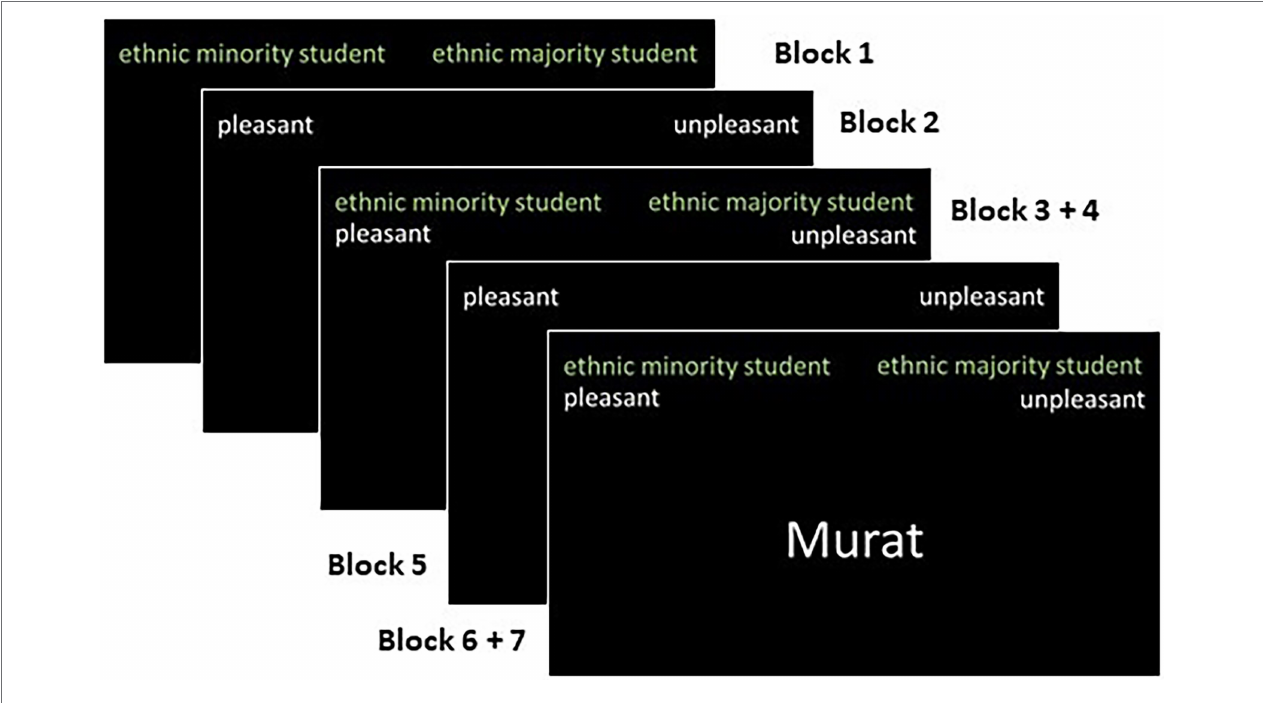
FIGURE 2 | Schematic presentation of the IAT.